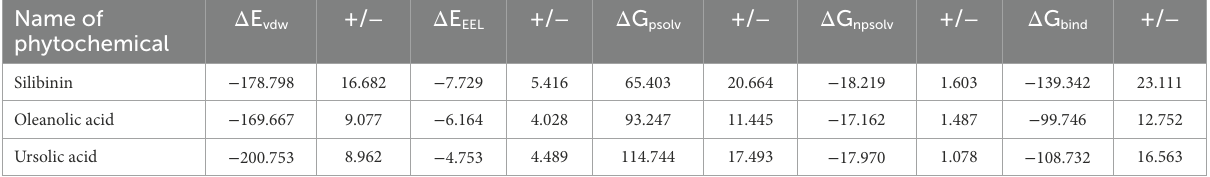
TABLE 2 Summary of energy components from MM/PBSA analysis of the lead phytomolecules with the D13 protein. Name of